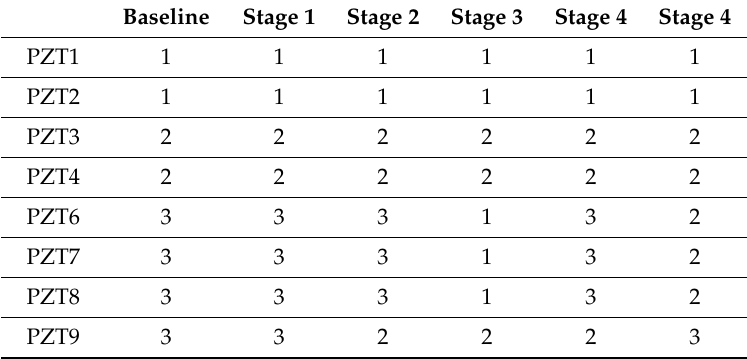
Table 1. K-means clustering result—beam